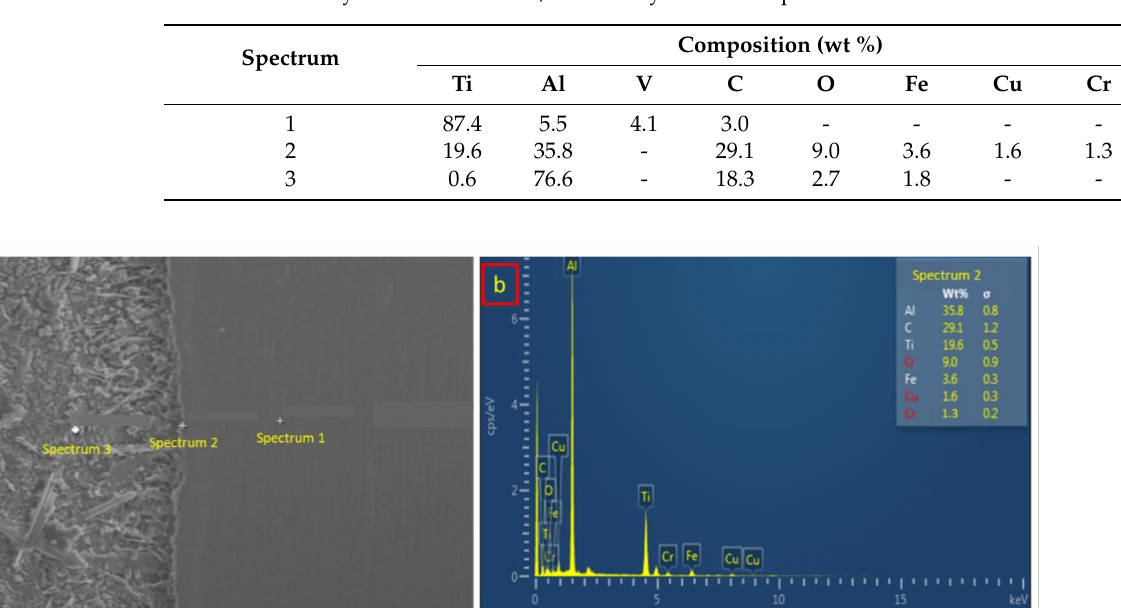
Table 6. EDX analysis results of the Ti/Al IMC layer from sample 3.